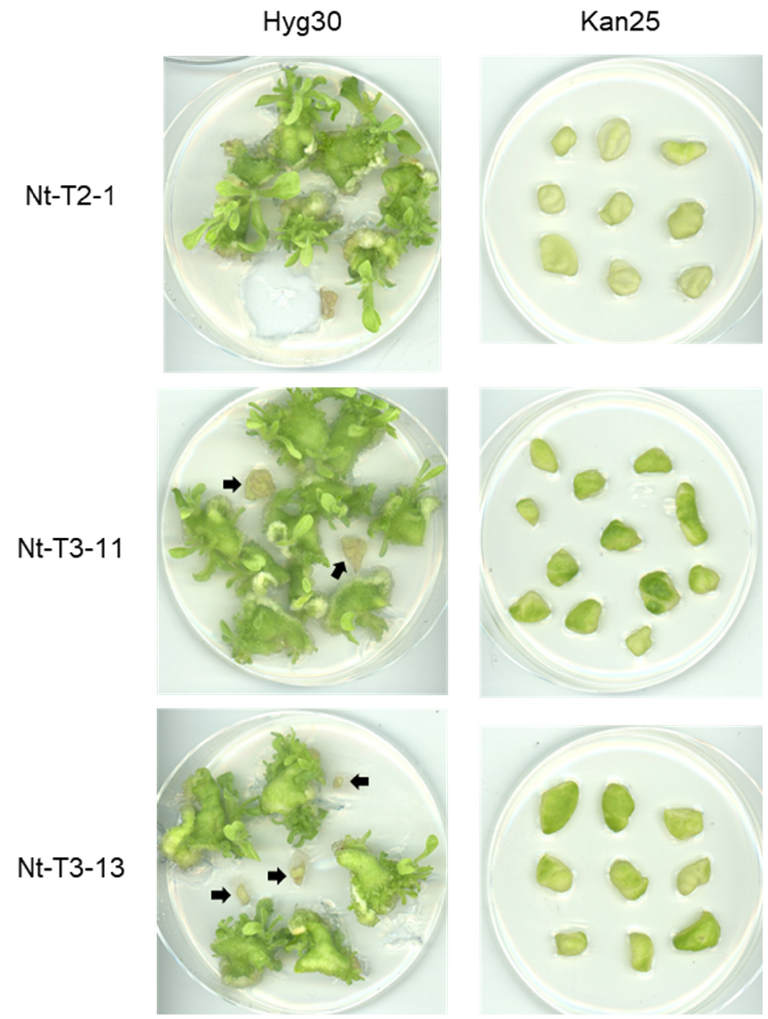
Figure 6. Effect of kanamycin on shoot regeneration of T 1 seedlings from T2-1, T3-11, and T3-13 lines. Hyg30, shoot induction media containing 30 mg/L hygromycin; Kan25, shoot induction media containing 25 mg/L. Leaf pieces from seedlings grown on antibiotic-free media were tested. Nt-T2-1, which did not have mutated alleles, serves as a control. Arrows indicate hygromycin sensitive leaf pieces (see main text).